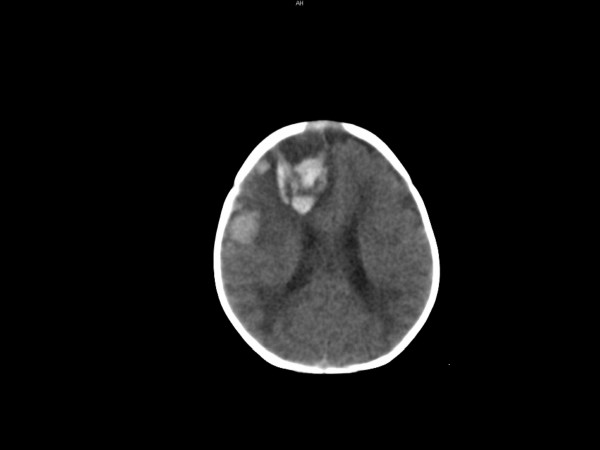
Computed tomography of the brain conducted at 5 weeks of age showing an intra cerebral hemorrhage.